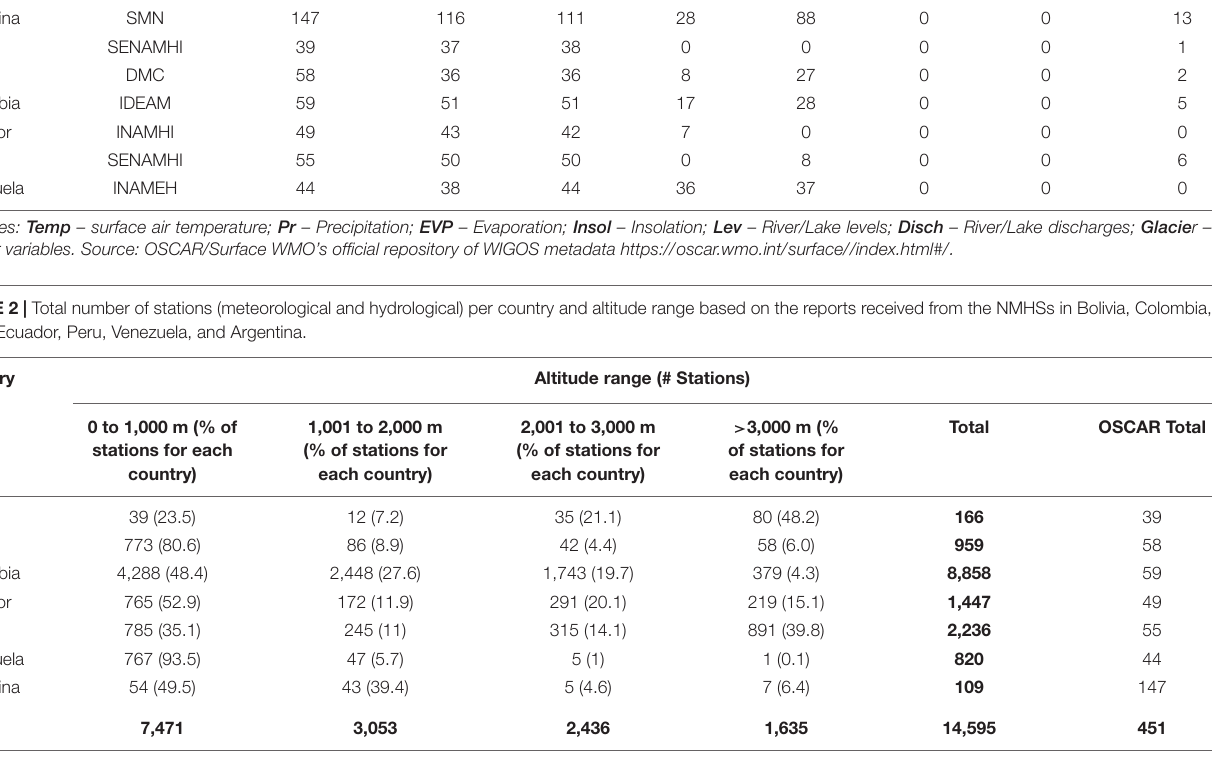
TABLE 1 | Number of surface hydrometeorological stations operated by the National Meteorological and Hydrological Services in the Andean Region reported in OSCAR. Country NMHS Total Temp Pr EVP Insol Lev Disch Glacier #Stations SMN 147 116 111